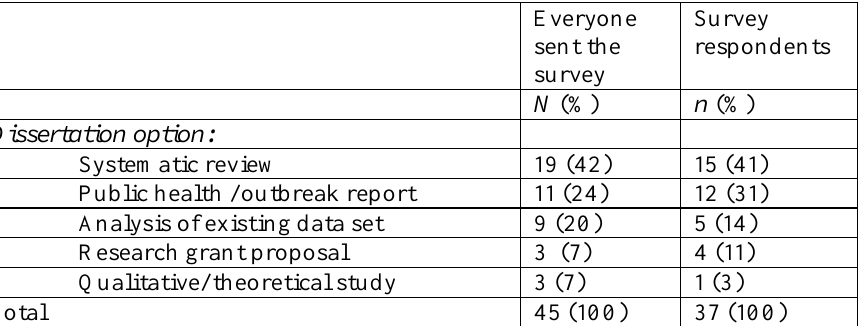
Everyone Survey sent the survey